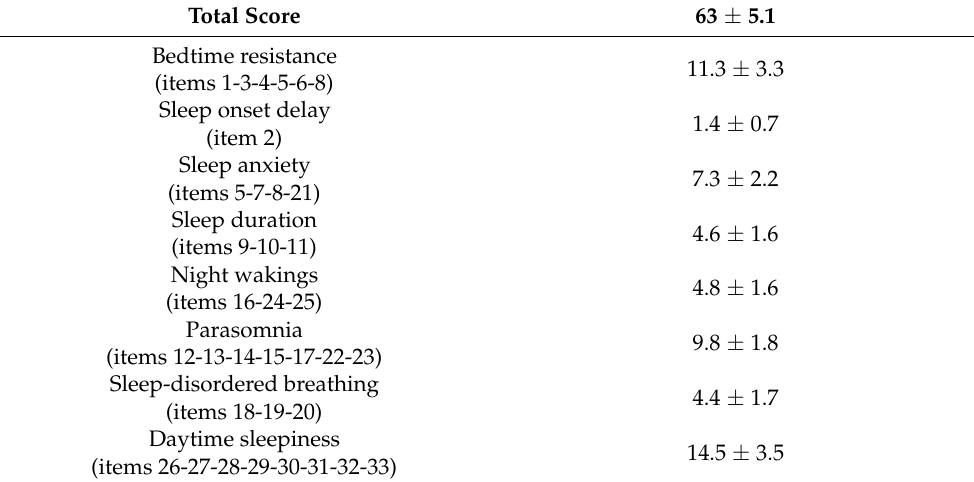
Table 1. Total and subscale scores of CSHQ-IT from mothers of 48 Down syndrome